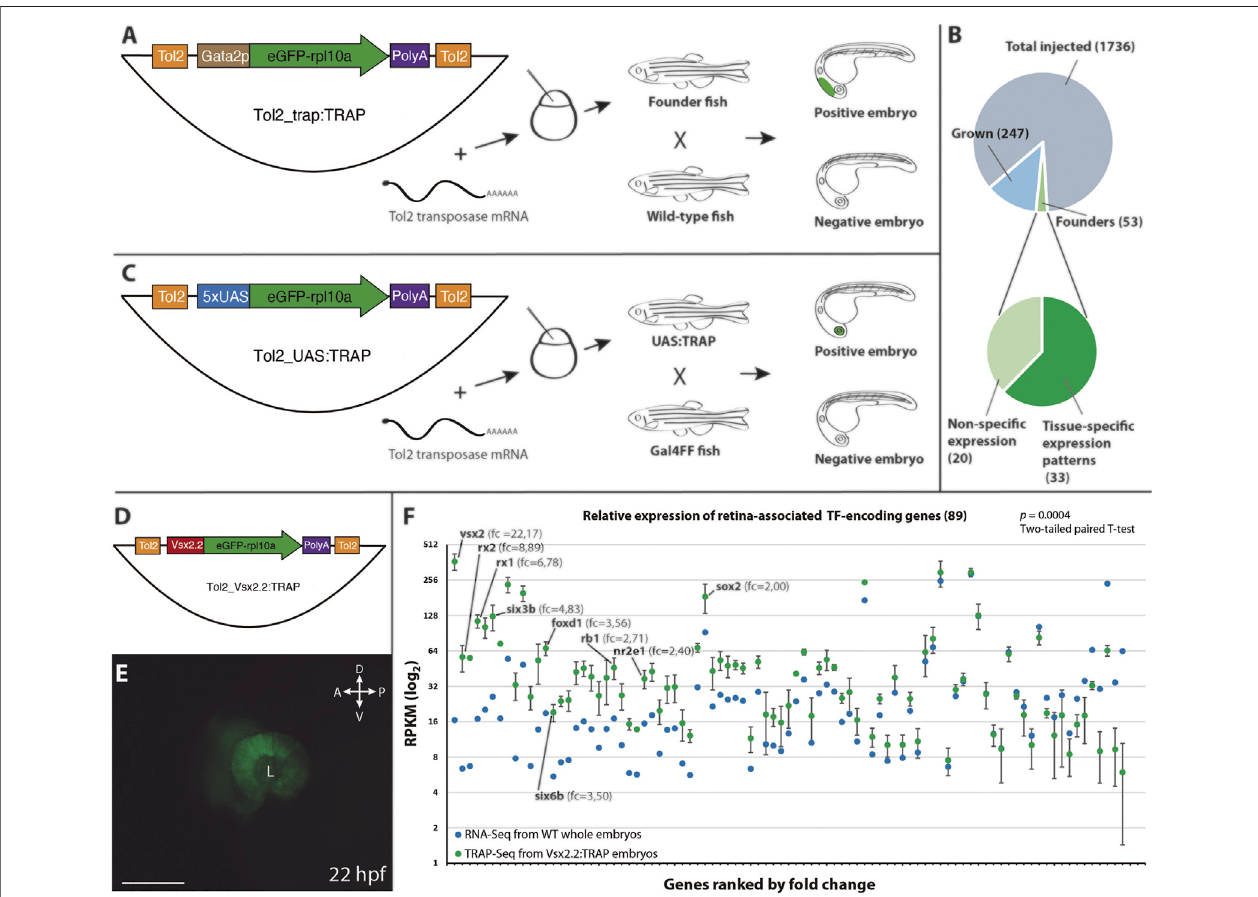
FIGURE 1 | Vectors and procedures used to expand TRAP approaches in zebra fi sh. (A) : The Tol2_trap:TRAP vector comprises a cassette containing the eGFP- rpl10a fusion gene (green) and the gata2p minimal promoter (brown), fl anked by Tol2 recognition sequences (orange). This vector was injected together with Tol2 transposasemRNA inone-cellstage zebra fi shembryos. Oncegrown,adult fi shwerescreenedforeGFP-rpl10a expression intheirprogeny. (B) :Pie chartsshowingthe ef fi ciency rate of the trap:TRAP approach. (C) : The Tol2_UAS:TRAP vector comprises a cassette that contains the eGFP-rpl10a fusion gene (green) together with the5xUASelement(blue), fl ankedbytheTol2recognitionsequences(orange).Thisvectortogetherwith Tol2transposase mRNAwereinjectedtogetherinone-cellstage embryos. Once grown, adult fi sh were outcrossed with a Gal4 line to identify founders. (D) : Schematic representation of the Tol2_vsx2.2:TRAP vector used to test the functionality of the eGFP-rpl10a cassette (green) under the control of the vsx2.2 promoter (red). (E) : Retina-speci fi c eGFP-rpl10a expression in the line Tg[vsx2.2:TRAP] tested in TRAP-seq experiments at 22 hpf. L, lens. Scale bar (cid:1) 100 µm. (F) : Differential expression (RPKM) of retinal TF-encoding genes in af fi nity-puri fi ed transcripts from vsx2.2:TRAP embryosat22 hpf(TRAP-seq, n (cid:1) 3,green),andin22 hpfwholeembryosRNA-seqsample(control,blue).Notethesigni fi cantexpressionenrichment ofneuralretina-associatedtranscriptionfactors(rankedbyfold-change)inthe vsx2.2:TRAP sample( p (cid:1) 0.0004 ;two-tailedpaired t -test).RPKMvaluescorrespondingto TFs from the core retinal GRN, as well as their fold change vs the control, are indicated.